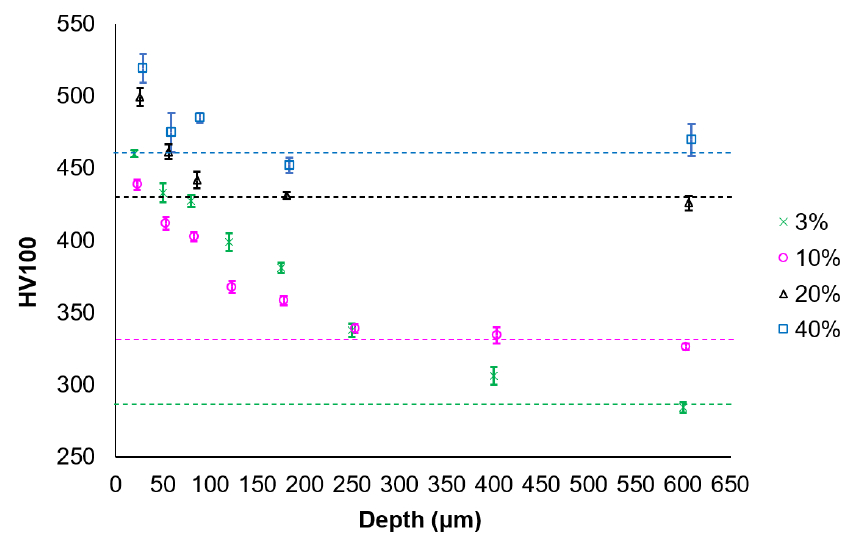
Figure 7. Deep hardness profiles for the UVABB tests in the parallel direction as a function of the initial martensite content. Discontinuous lines: core material